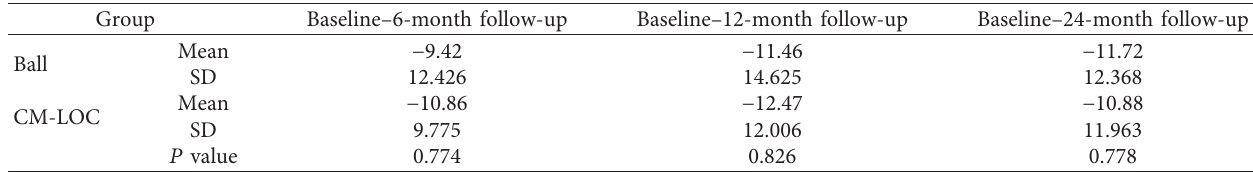
Figure 5: Mean scores for masticatory ability for the two attachments used, ball and CM-LOC attachment, throughout the 24-month follow-up interval. Table 5: Mean scores and standard deviation of change in masticatory ability from baseline to 6-, 12-, and 24-month follow-up for patients of the ball and CM-LOC attachment group.